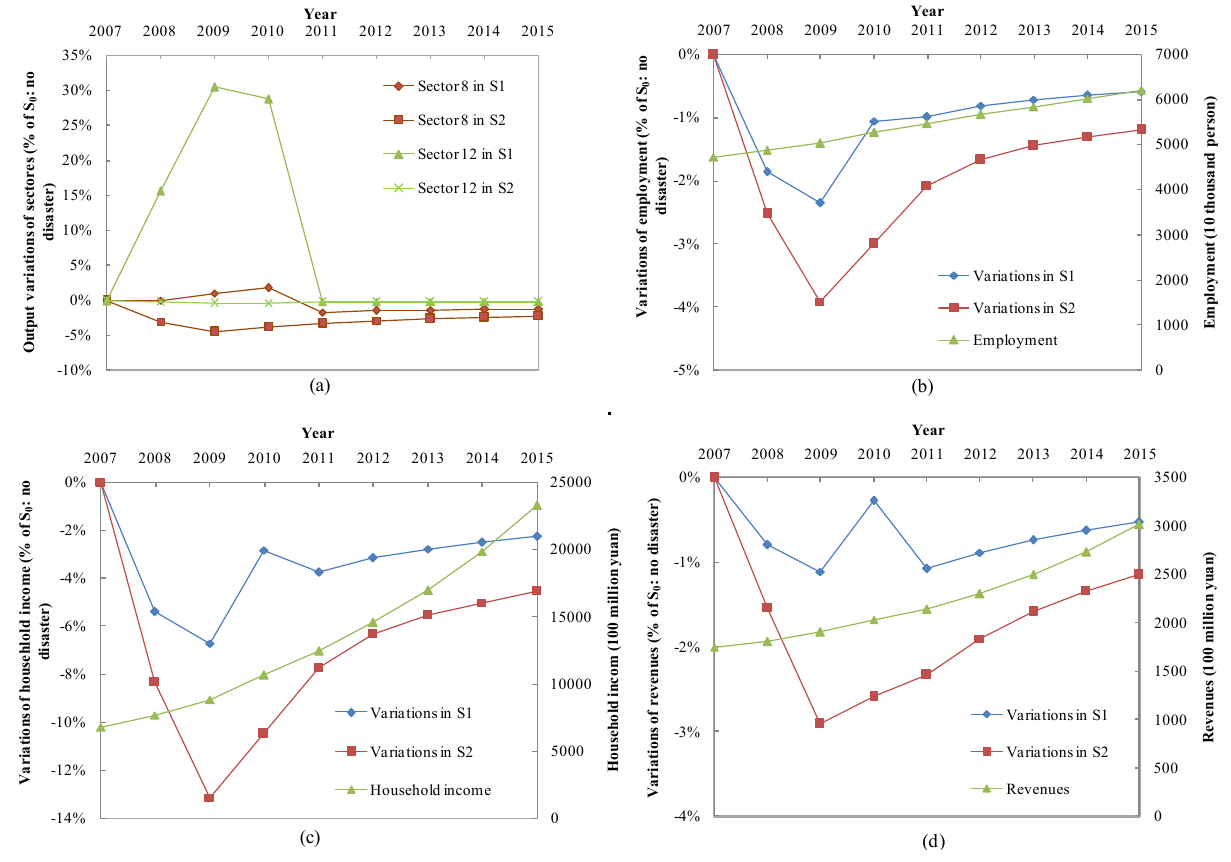
Fig. 5. The recovery process of post-disaster economic systems under different scenarios.